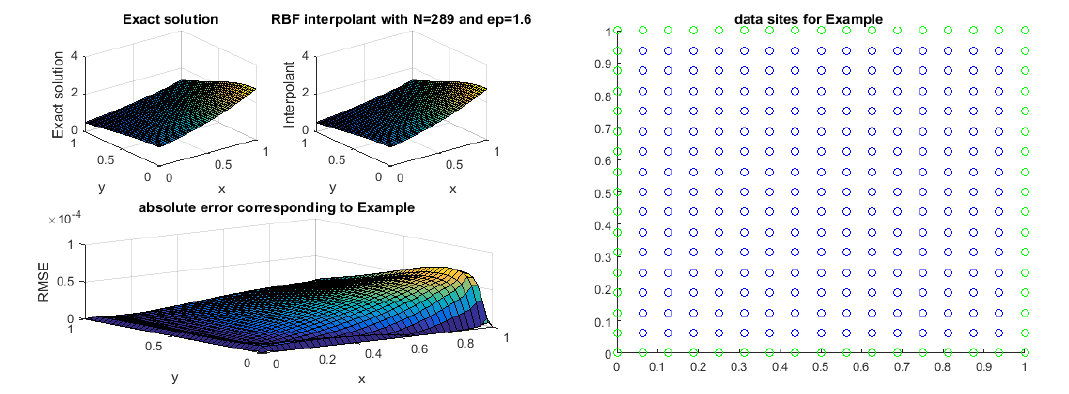
Figure 5. The approximate solution for Example 2 and its corresponding RMSE for different n